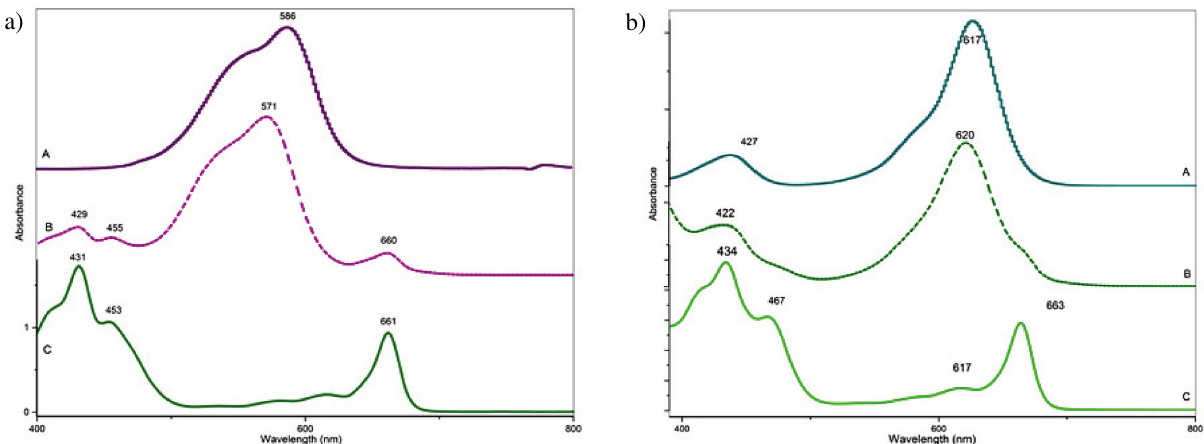
Fig. 4. UV-Vis spectra of the CV and MG diluted in EtOH (A), the phytoaccumulated CV and MG content extracted with EtOH from Lemna minor (B), and the photosynthetic pigments extracted with EtOH from control Lemna minor (C) [ The a) for the CV and b) for the MG dye ] .